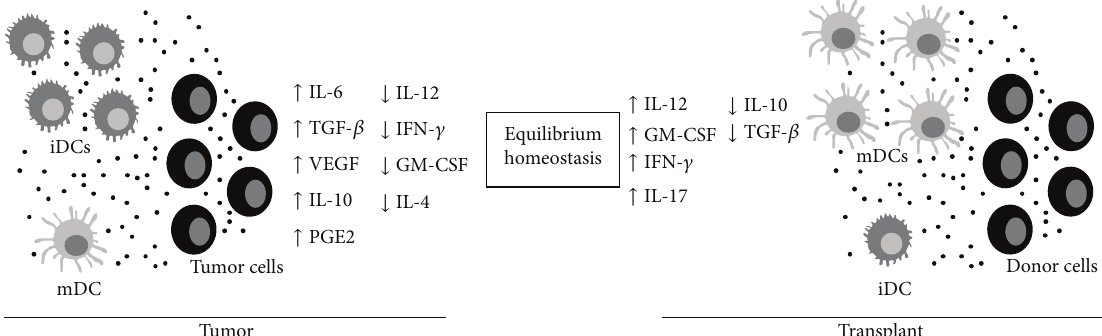
Figure4:Schematicillustrationshowingthedifferencesbetweentumorandtransplantsmicroenvironments.Immaturedendriticcells(iDCs) are present in higher number in tumor microenvironments, while activated dendritic cells (mDCs) can be more easily found in transplanted organs. In both cases, tumor cells or donor cells and dendritic cells are in constant communication through cytokines and other factors secretion (represented by small black circles). In the tumor microenvironment, factors that are generally suppressive to dendritic cells are present in big amounts. On the other hand, in transplants, proinflammatory cytokines which exacerbate dendritic cells function are